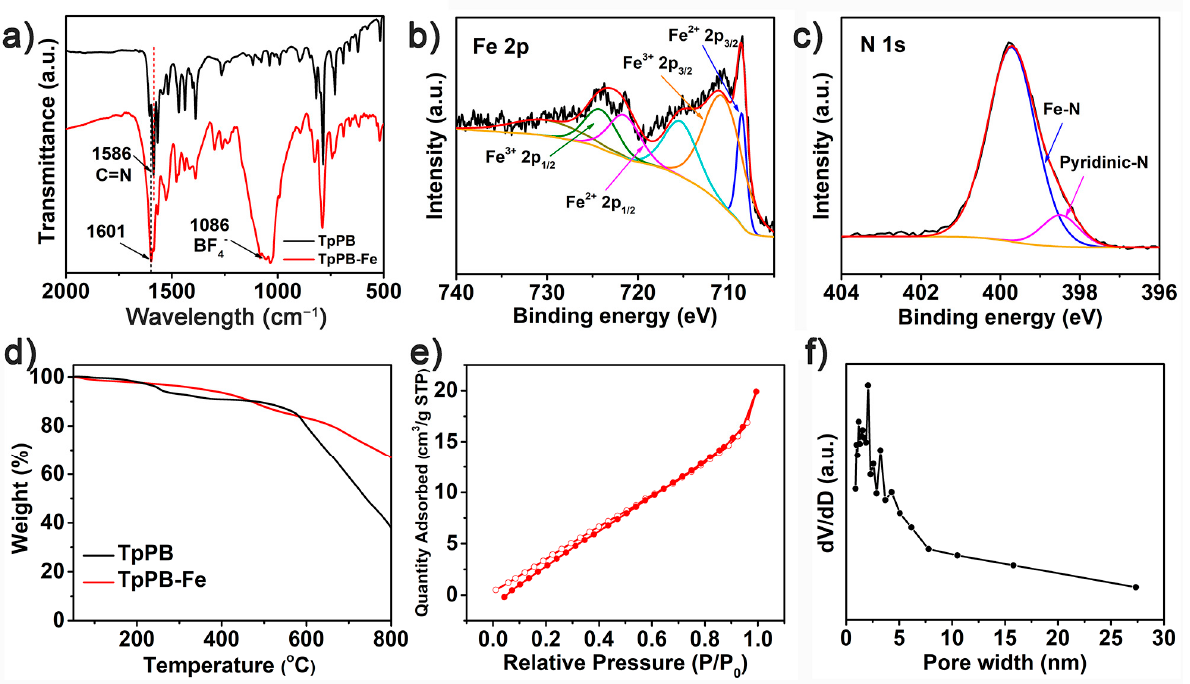
Figure 3. ( a ) The FTIR spectrum of TpPB-Fe coordination polymer between ( b ) Fe 2p and ( c ) N 1s XPS spectra of TpPB-Fe; ( d ) TGA curve of TpPB and TpPB-Fe; ( e ) Nitrogen adsorption/desorption isotherm of TpPB-Fe; ( f ) pore size distribution for TpPB-Fe.